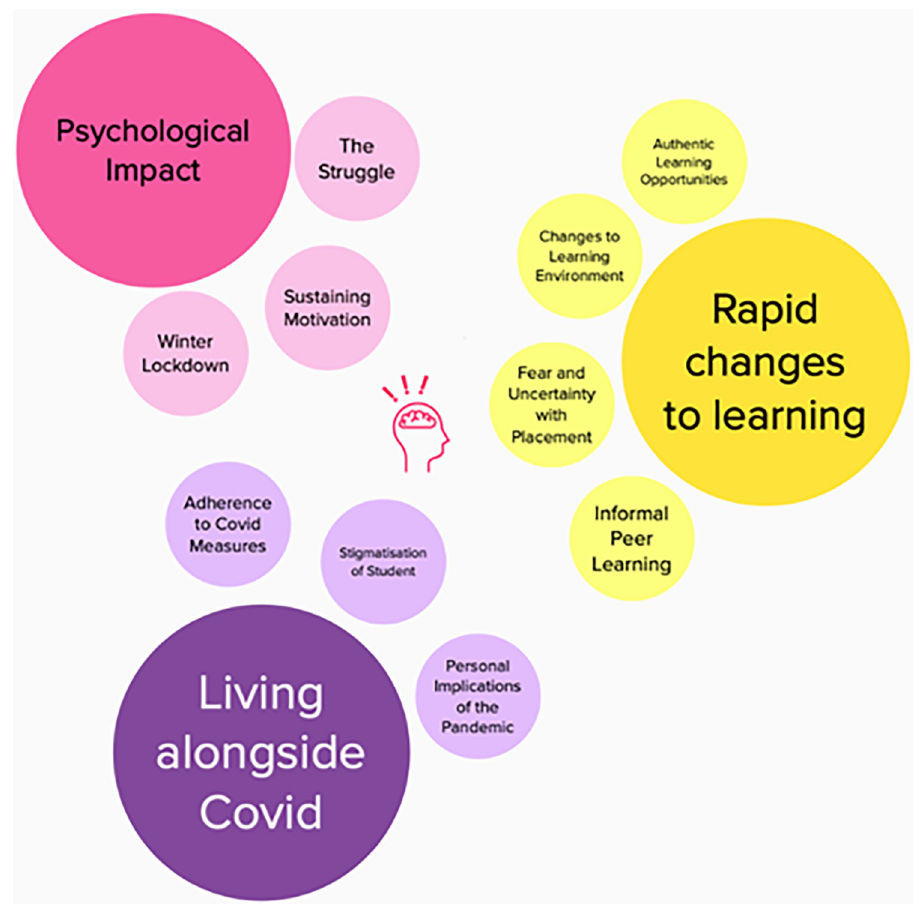
Fig 2. Extract of final themes co-developed by student and academic researchers on the platform